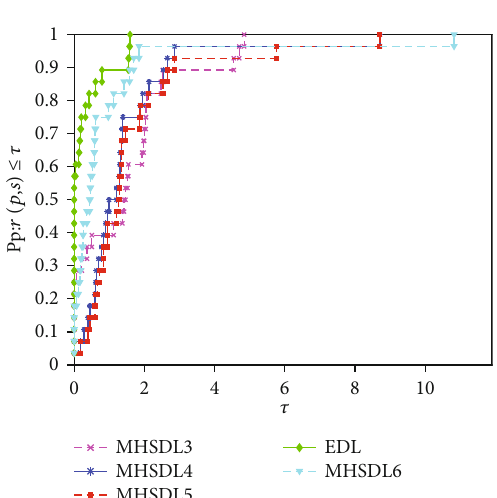
Figure 1: NI performance pro fi le for EDL, MHSDL3, MHSDL4, MHSDL5, and MHSDL6